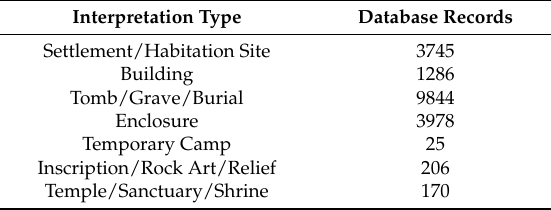
Table 2. Examples of resource interpretation types (including site types and features).